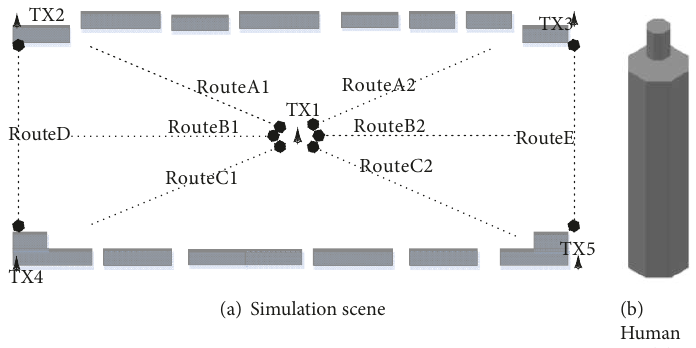
Figure 1: Simulation scene and human model.